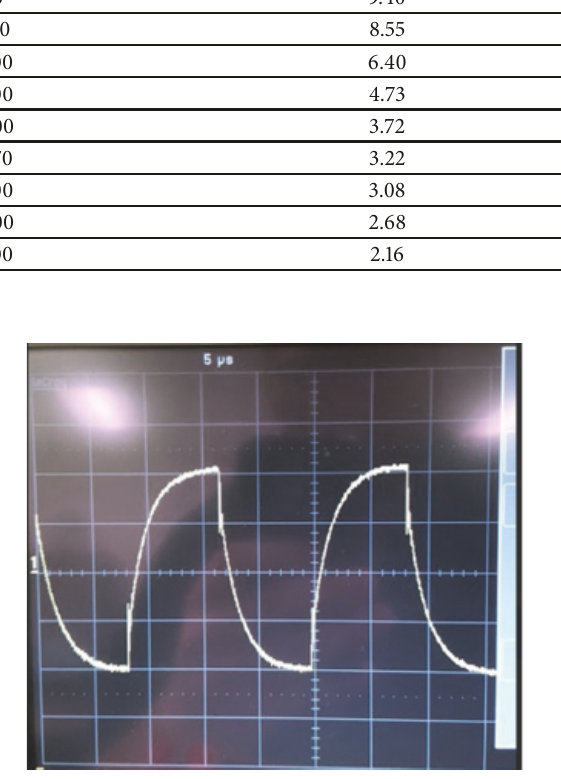
Figure 15: Output waveform of the LSGC connected in series with a 100 𝑘Ω resistor with an input 10V peak to peak square